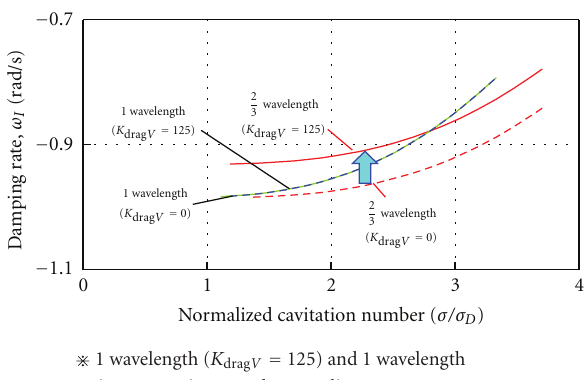
Figure 12: E ff ect of valve resistance in inlet line using CFD- calculated K and M , supposing K drag = 0.